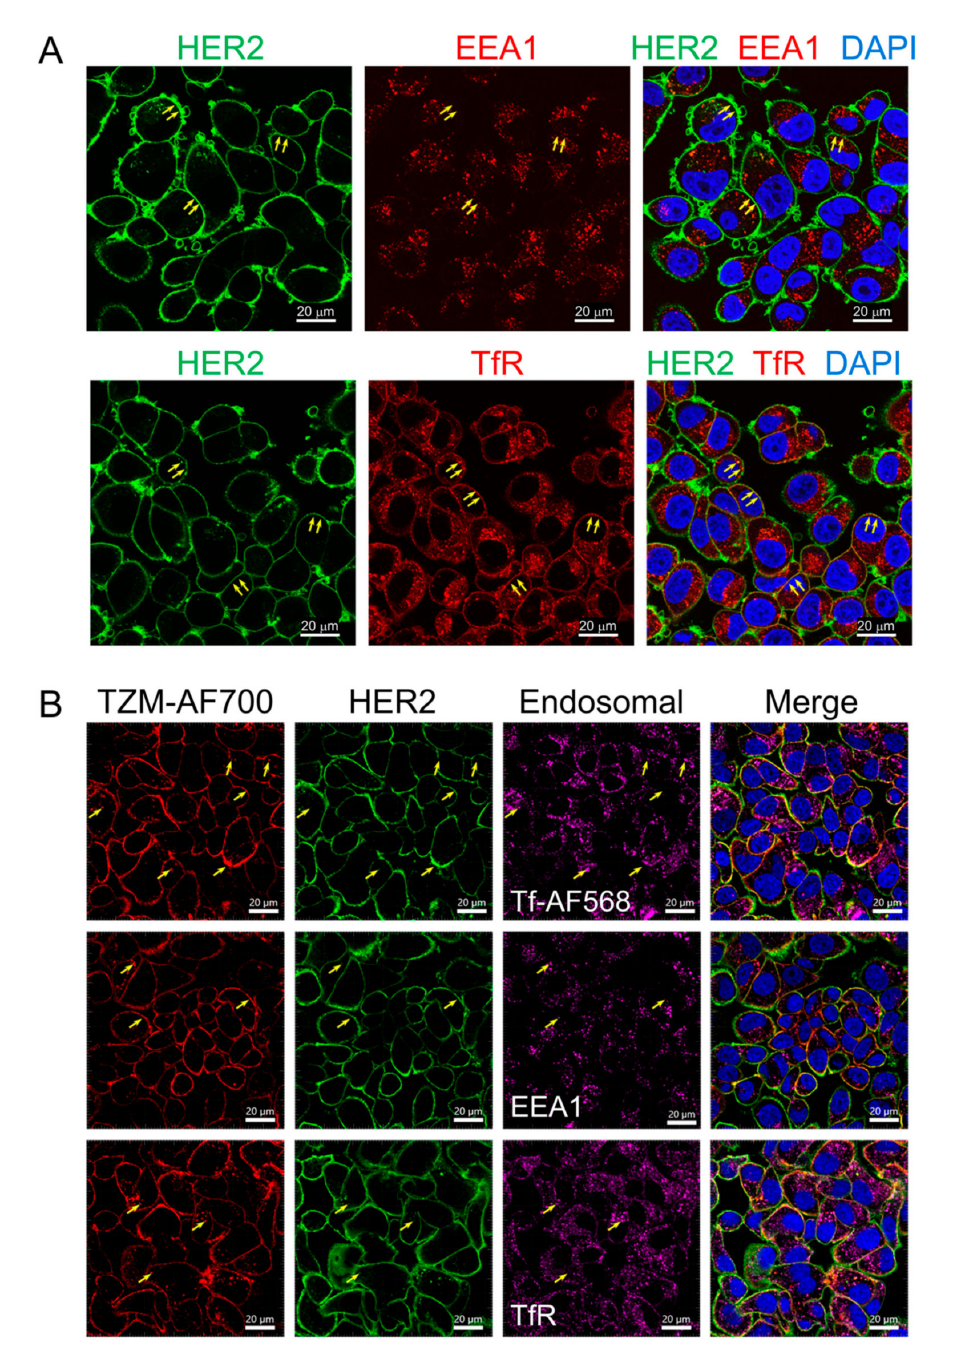
Figure 1. Confocal microscopy of Human EGF Receptor 2 (HER2) and trastuzumab (TZM)–AF700 distribution in AU565 cells. ( A ) Immunofluorescence analysis of HER2 (green; arrows), early endosomal antigen 1 (EEA1), or transferrin receptor (TfR) (red; arrows). Middle slices of z-stacks consisting of 6–8 optical slices are shown. ( B ) AU565 cells were loaded with 5 µ g / mL TZM–AF700 (red) and 5 µ g / mL Tf–AF568 (magenta) for 24 h and then processed for immunostaining of HER2 (green) and endosomal markers EEA1 or TfR (magenta). Maximum intensity projections of z-stacks consisting of 6–8 optical slices are shown. Nuclei are visualized with DAPI. Scale bar = 20 µ